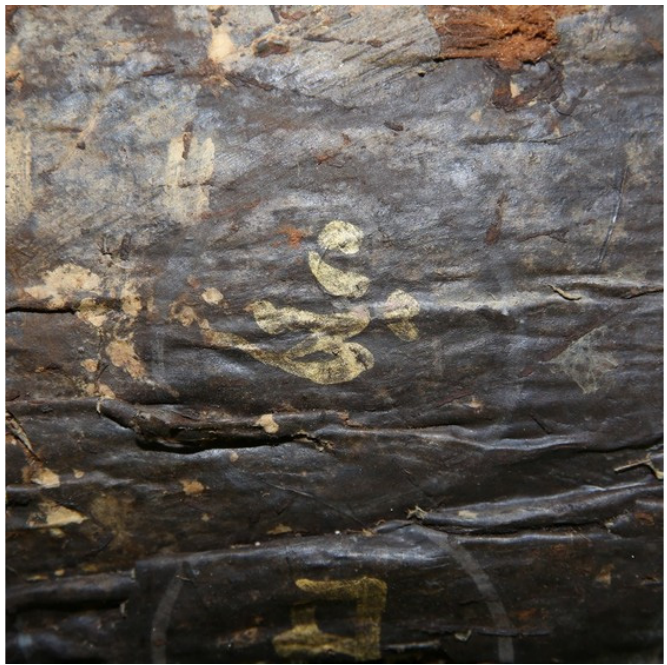
Figure 14. The Siddha ṃ letter O ṃ inscribed on the exterior of the Nongso coffin.